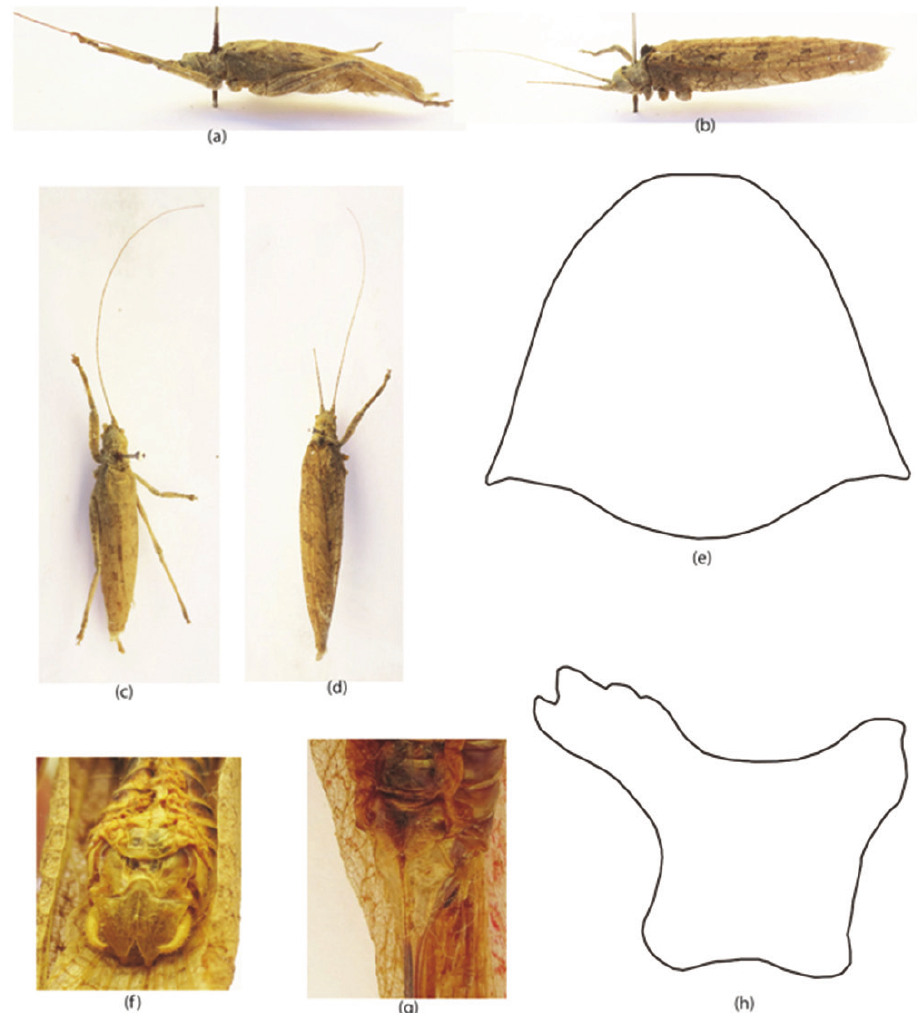
Figure 2. Sathrophyllia femorata a–h Male & Female a adult male LV b adult female LV c adult male DV d adult female DV e pronotum male DV f male subgenital plate g female subgenital plate h prono- tum male